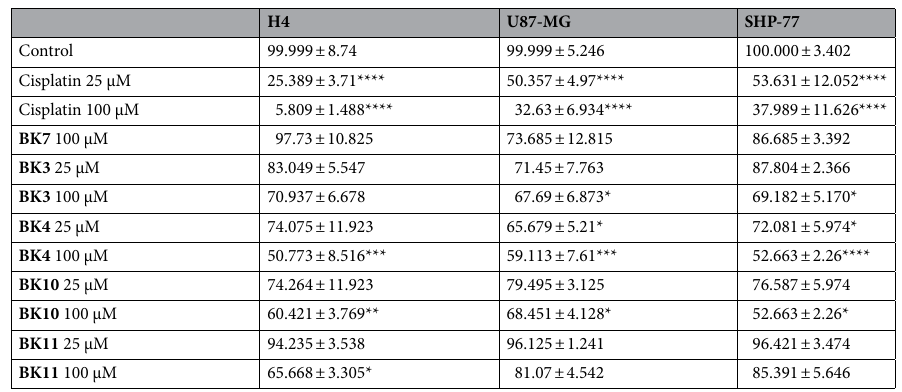
Table 2. The effects of B1R antagonists (BK7, BK3, BK4, BK10, and BK11) and cisplatin on cancer cell lines (H4, U87-MG, and SHP-77) using MTT assay. Data were normalized to absorbance in the control group (100%) and are expressed as a percentage of control and presented as mean ± SEM obtained from n = 3 wells per experiment from 2–3 independent experiments. **** p < 0.0001; *** p < 0.001; ** p < 0.01; * p < 0.05 (one-tailed ANOVA and Tukey post hoc test).